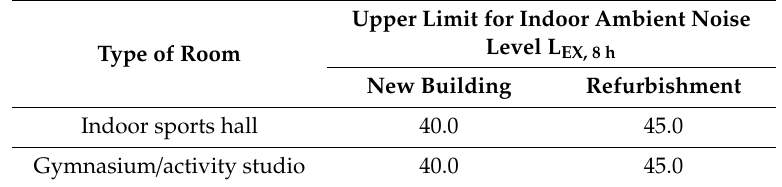
Table 4. Noise for indoor sports and gymnasia (IS & G) halls according to Building Bulletin (BB) [1]. Type of Room Upper Limit for Indoor Ambient Noise Level L EX, 8 h